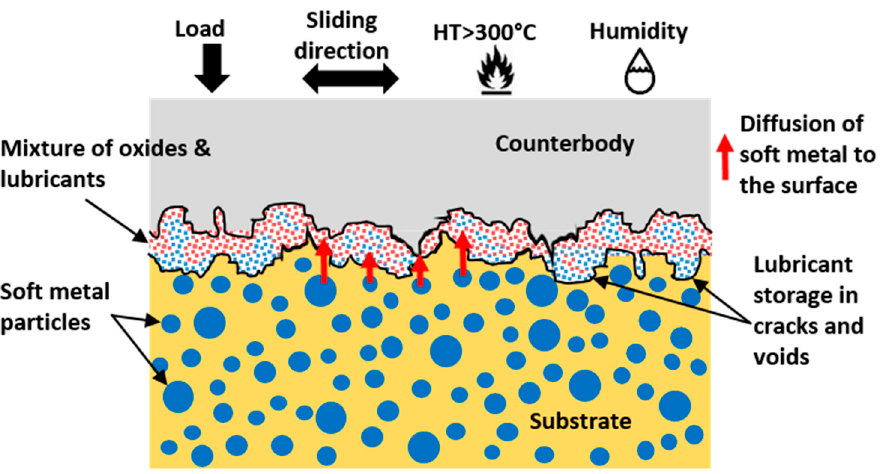
Figure 3. Diffusion mechanism of soft metal ‐ based solid lubrication during HT tribological opera ‐ tions.